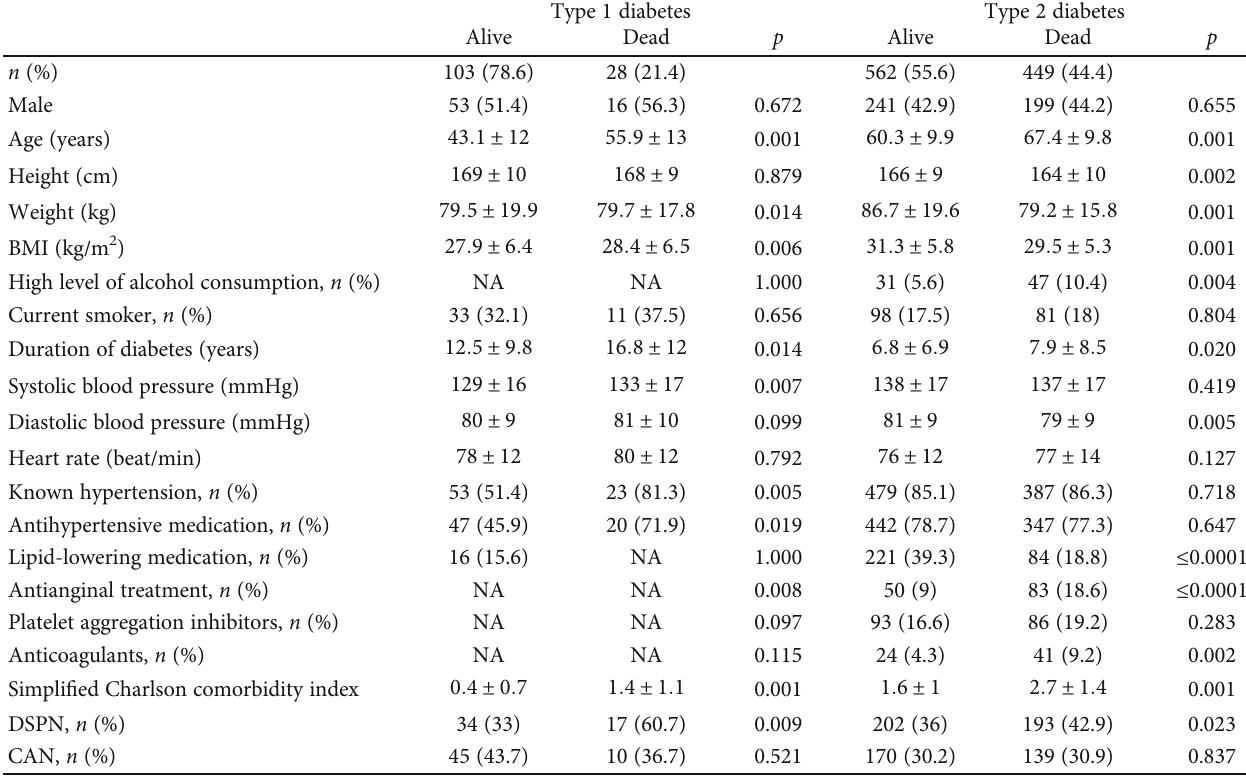
Table 1: Baseline characteristics of participants by type of diabetes and survival status.